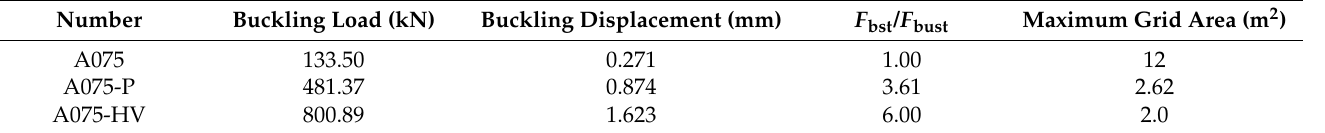
Table 4. Buckling performance of SPSW.